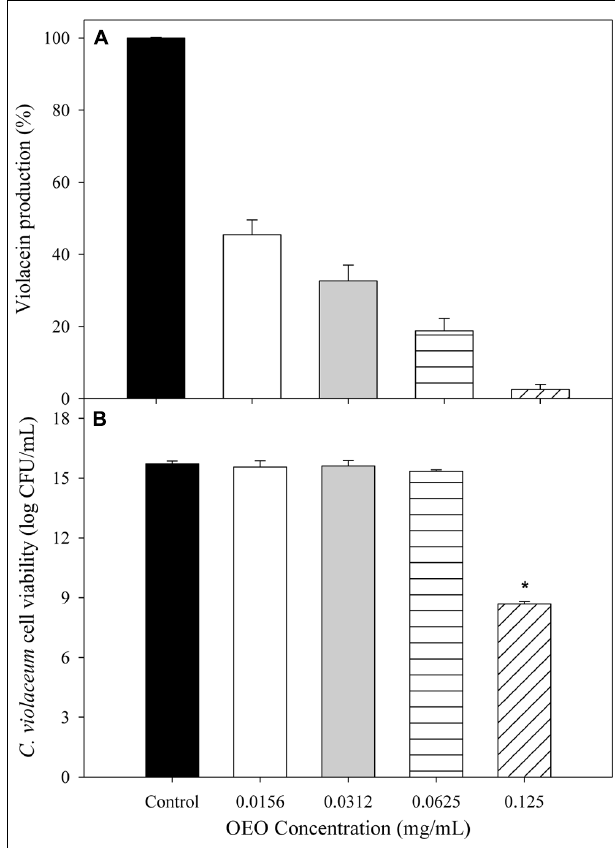
FIGURE 2 | (A) Inhibition of violacein production of C. violaceum exposed to different concentrations of OEO enriched pectin films in LB broth, using films prepared by incorporation of 15.7, 25.9, and 36.1 mg/mL of OEO. Different letters among bars indicated significant differences ( p < 0.05). (B) C. violaceum cell viability after incubation in LB broth enriched with different concentrations of OEO enriched films in LB broth. Different letters among bars indicated significant differences ( p <